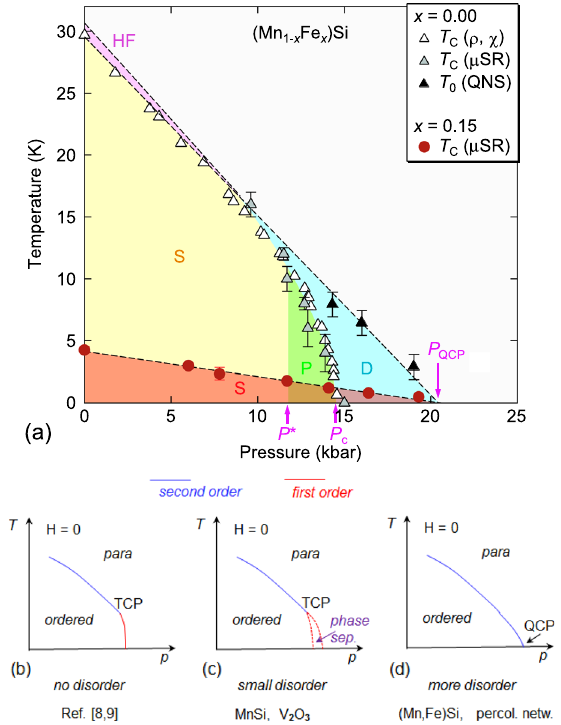
Fig. 1 Temperature – pressure phase diagrams of MnSi and (Mn,Fe)Si. a Temperature versus hydrostatic pressure phase diagram in pure MnSi and (Mn,Fe)Si in zero magnetic fi eld. Open triangles represent the magnetic transition temperature determined by resistivity and susceptibility, 11 gray-colored triangles from MuSR, 13 and closed triangles represent the onset temperature of diffuse scattering “ partial order ” in quasi-elastic neutron scattering (QNS). 12 The yellow-colored region (S) represents the helically ordered phase, the green colored region (P) indicates phase separation between ordered and paramagnetic phases, and the blue colored region (D) indicates slow, dynamic, diffusive helical spin fl uctuations. 12, 13 The small pink region (HF) above T C has helical spin fl uctuations leading to a weakly fi rst-order thermal transition. Red circles indicate the transition temperature for (Mn 0.85 Fe 0.15 )Si, determined by the present MuSR measurements. b – d Expected phase diagrams of itinerant- electron magnets according to theories by Belitz, Kirkpatrick and co-workers 8, 9, 34 – 37 with the effect of disorder. TCP denotes the tri- critical point and QCP denotes the quantum critical point. The blue line indicates a second-order phase transition, while the red line shows a fi rst-order phase transition. The fi rst-order line in b intersects the p axis vertically at T = 0. The MuSR results for pure MnSi 13 can be viewed as a manifestation of case c , and the present results for (Mn,Fe)Si as case d . The recent MuSR results on V 2 O 340 may correspond to c , while the second-order phase transition in a highly random percolation network may be related to